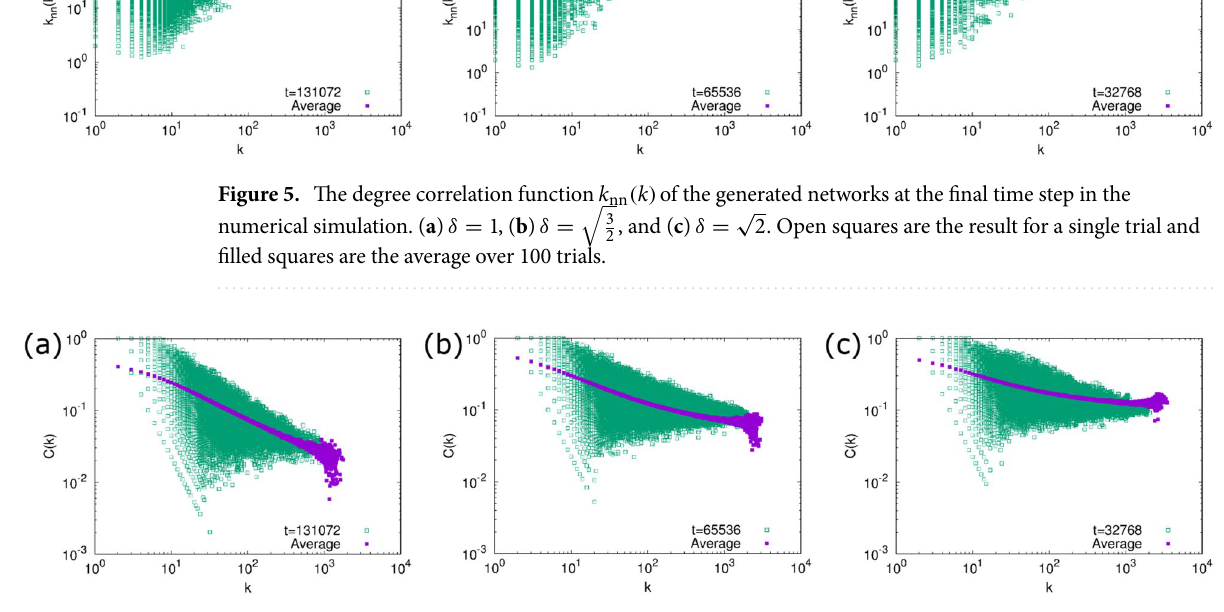
Figure 6. The local clustering coefficient C ( k ) of the generated networks at the final time step in the numerical 3 √ 2 . Open squares are the result for a single trial and filled 1 , ( b ) δ δ simulation. ( a ) δ 2 , and ( c ) = (cid:31) = = squares are the average over 100